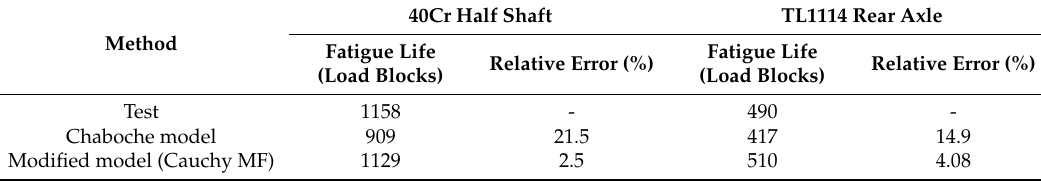
Table 3. Comparisons on fatigue lives between damage models and